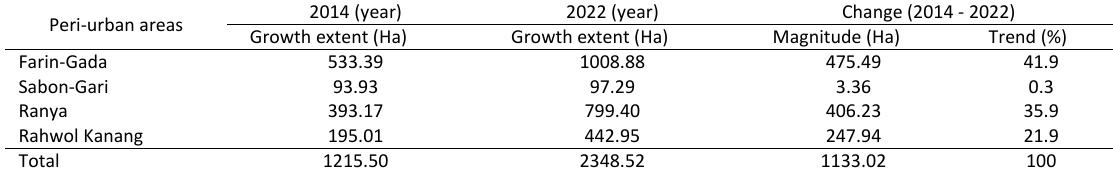
Table 6: Spatial growth of the study area from 2014 to 2022